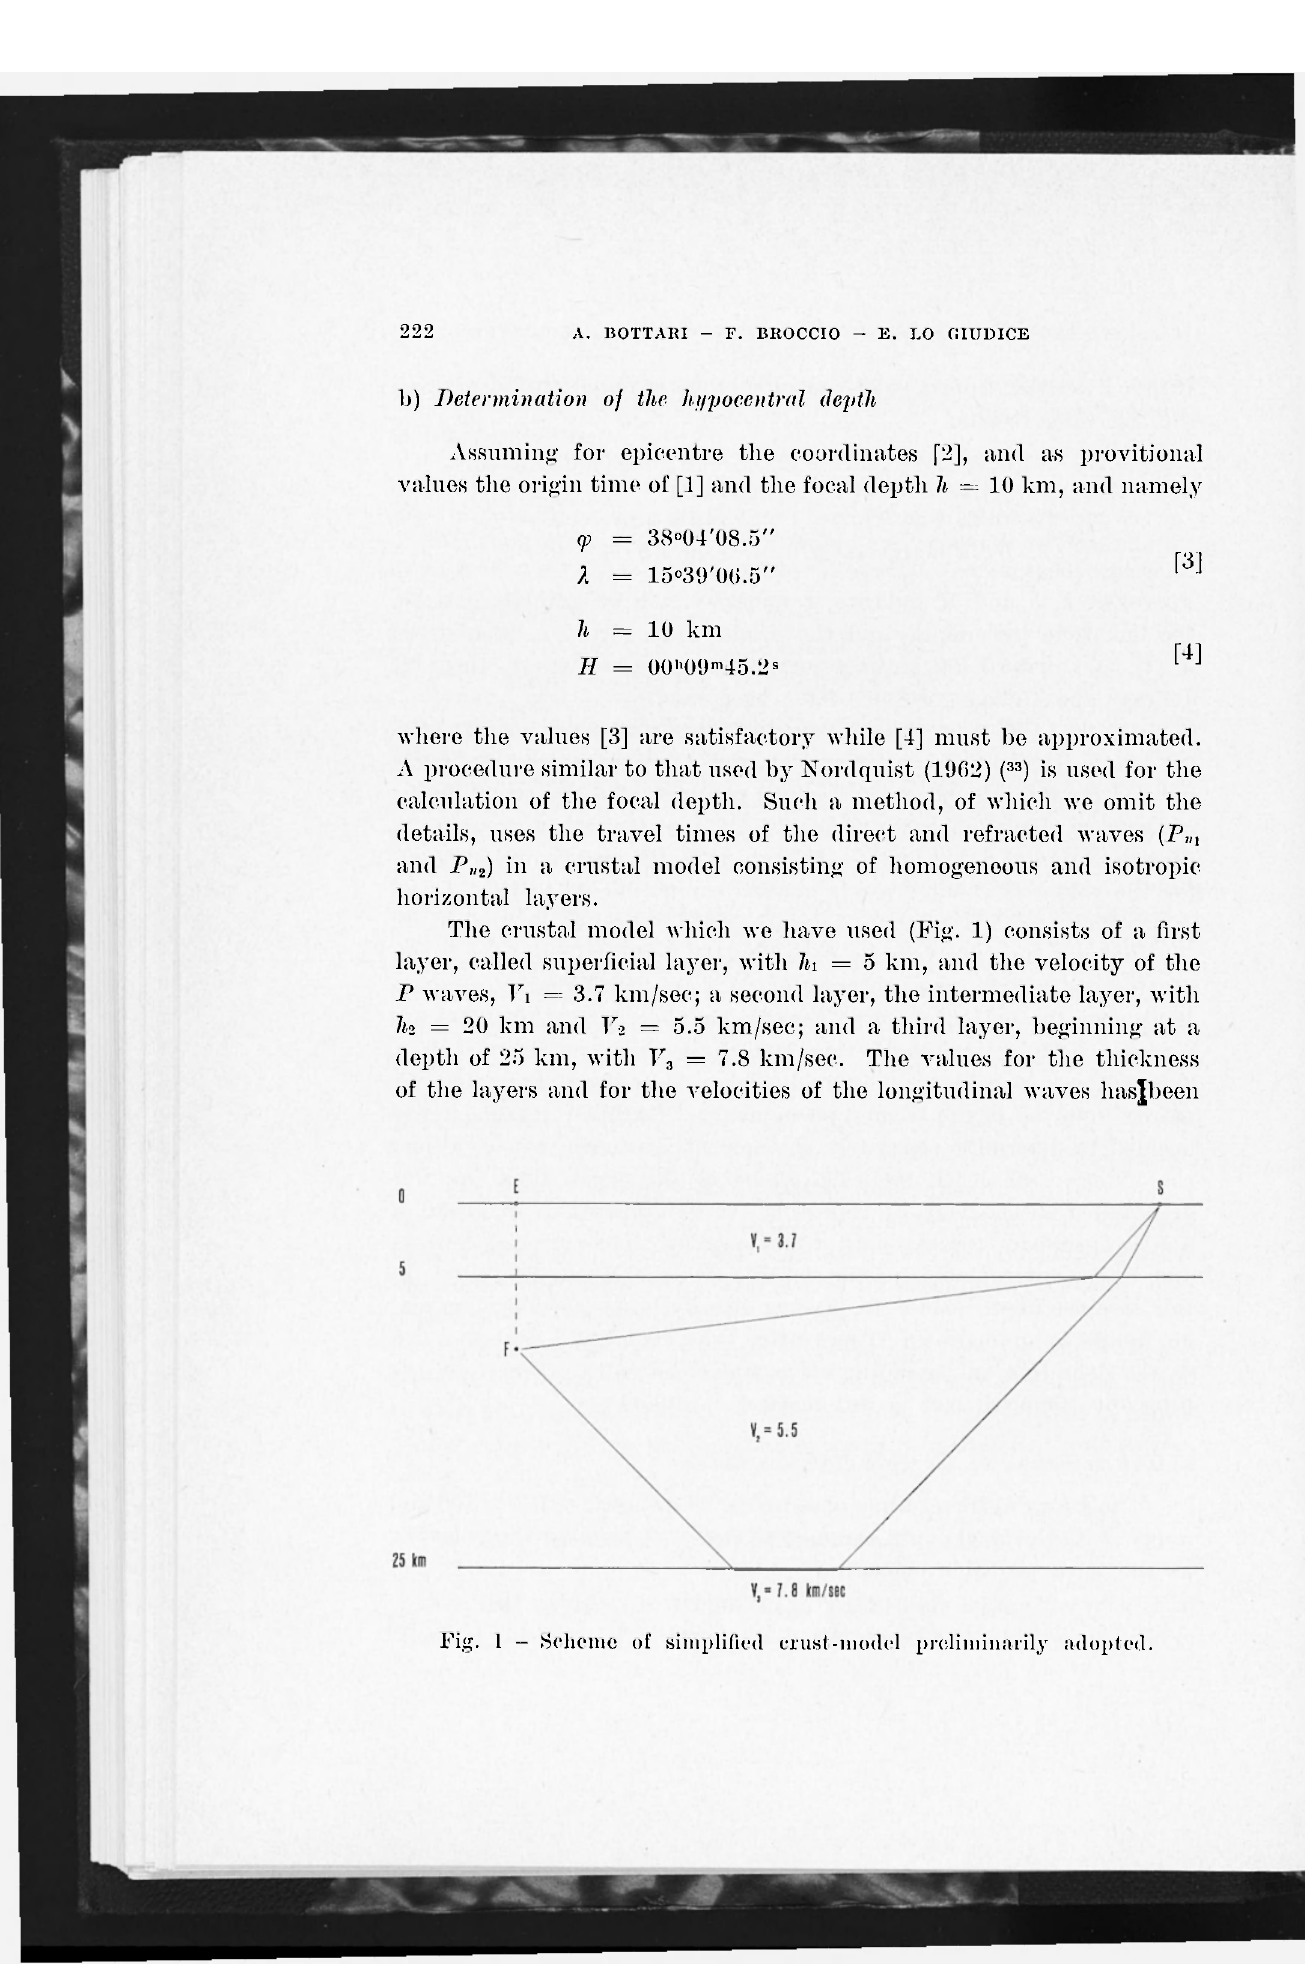
Fig. L Schemc of simplified crust-model preliminarily